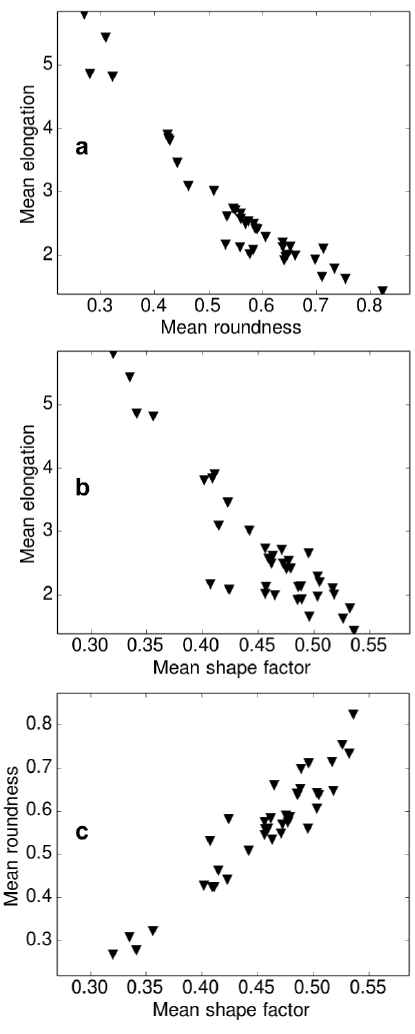
Figure 13. Comparison between mean shape parameters measured for real snowflakes. Higher elongation means lower roundness (a) and lower shape factor (b) , lower roundness means lower shape fac- tor (c) (and vice